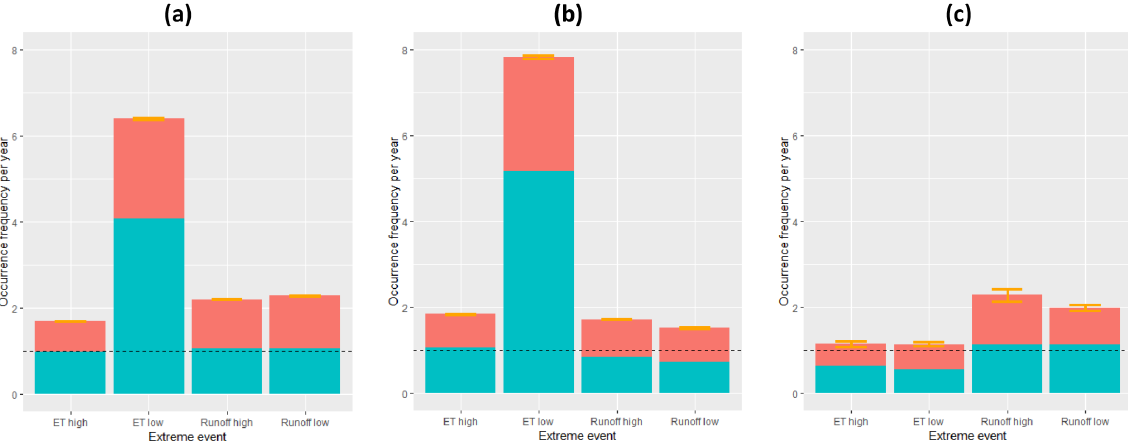
Figure 8. Global mean values (averaged over 50 ◦ S to 50 ◦ N) from scatter plots in Figs. 5–7. Plots show (a) all values, (b) values from dry environments with mean annual precipitation < 1000mmyr − 1 only and (c) values from wet environments ≥ 6000mmyr − 1 only. Bar heights are ε values (scaled total uncertainty), with blue showing α values (scaled data uncertainty) and red β (scaled model uncertainty); error bars show